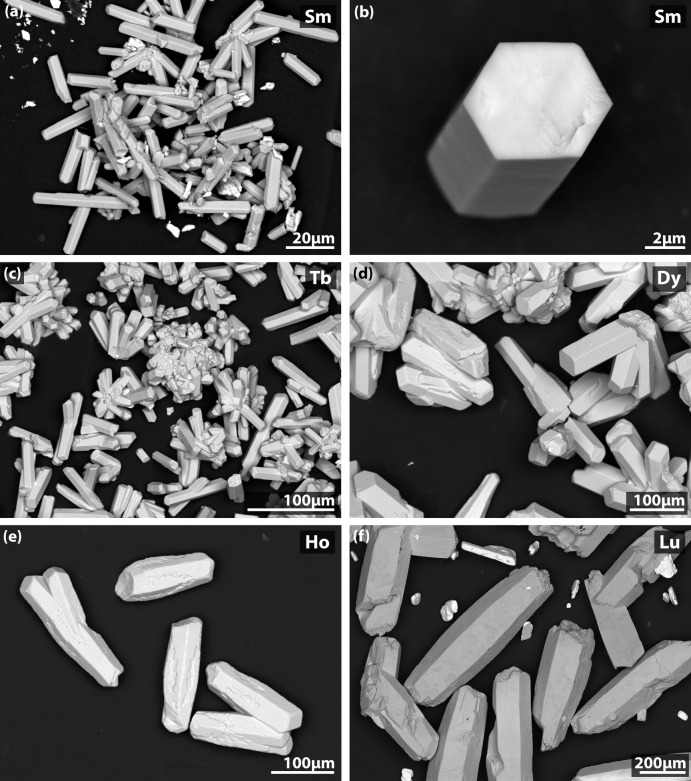
Back-scattered electron SEM micrographs of REAl3(BO3)4 crystals including (a) and(b) SmAl3(BO3)4, (c) TbAl3(BO3)4, (d) DyAl3(BO3)4, (e) HoAl3(BO3)4, and (f) LuAl3(BO3)4. Note that some KLu(MoO4)2 crystals are seen in (a) and (d) as the smaller and brighter crystallites.